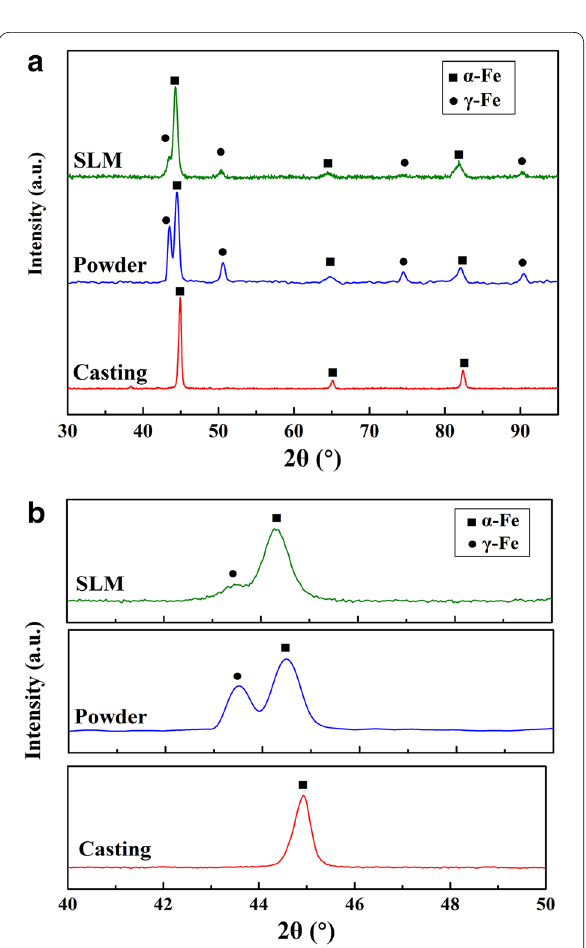
Figure 3 XRD patterns of a S136 powder, casting and SLM part; b enlargement of the α‑Fe diffraction